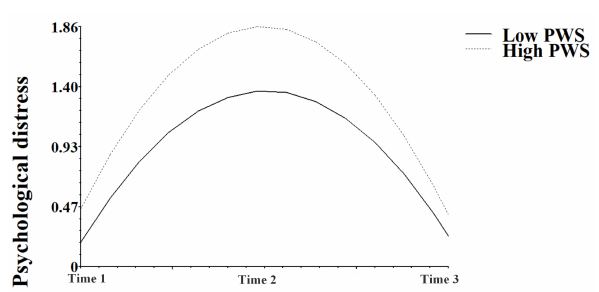
Fig. 2. The trajectory for high and low PWS boys across dif- ferent periods of COVID-19. PWS, perceived weight stigma; In the 10-items of PWS, those with 5 or more responding “yes” are classified as high PWS (n =